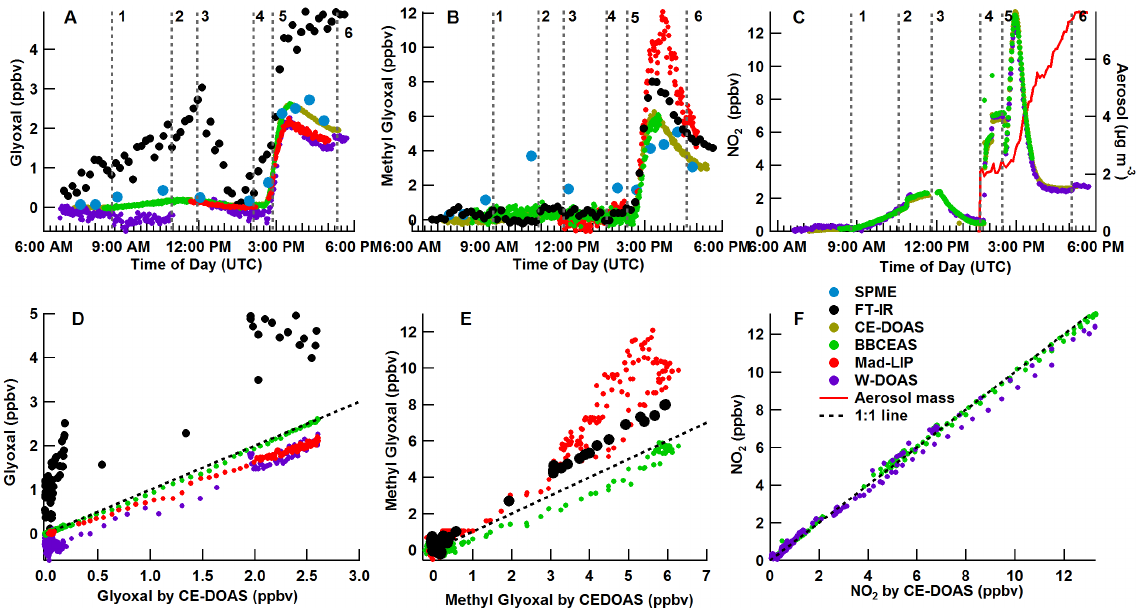
Figure 7. Dry photo-oxidation of o -xylene during experiment E3. (a–c) show the time traces of glyoxal, methyl glyoxal and NO 2 , respec- tively. (d–f) show the correlation plots of the respective compounds. E3 began in the morning with a clean, flushed chamber. The chamber roof was opened (1) while clean and the build-up of NO 2 and other contaminates was observed and then closed (2) and flushed clean (3). In the afternoon, HONO was added to the chamber (4) and with it some NO 2 , then the chamber roof was opened (5) to initiate the photo-chemistry and closed to finish the experiment